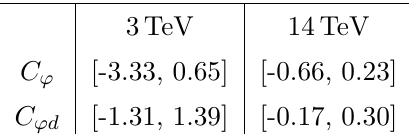
Table 8 . Marginalized projected limits at 95% con(cid:12)dence level on the Wilson coe(cid:14)cients in TeV (cid:0) 2 . particular, while O a(cid:11)ects only HH and HHH production, O ’ coupling. This means that the total rate of single Higgs production is a(cid:11)ected by O